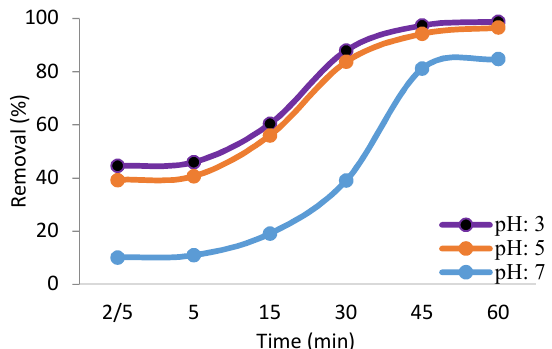
Fig. 3. Changes in the efficiency of erythrombin B dye removal at different pH and contact time in the US/S 2 O 82- process (concentration of erythrysine B, 50 mg/L and persulfate, 0.003